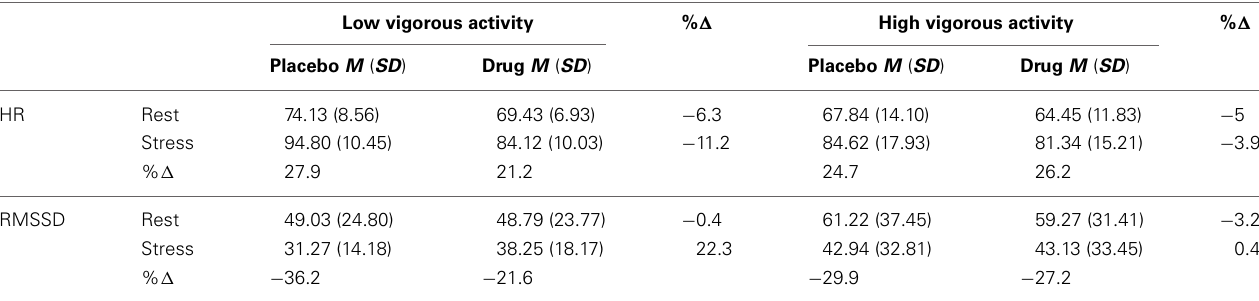
Table 2 | HR and RMSSD means and standard deviations for vigorous exercise groups under each treatment for rest and stress